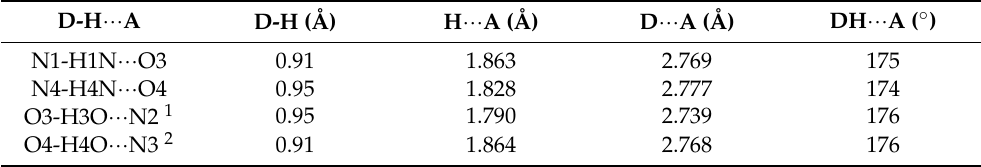
Table 5. Intermolecular H-bond data for P1 ·